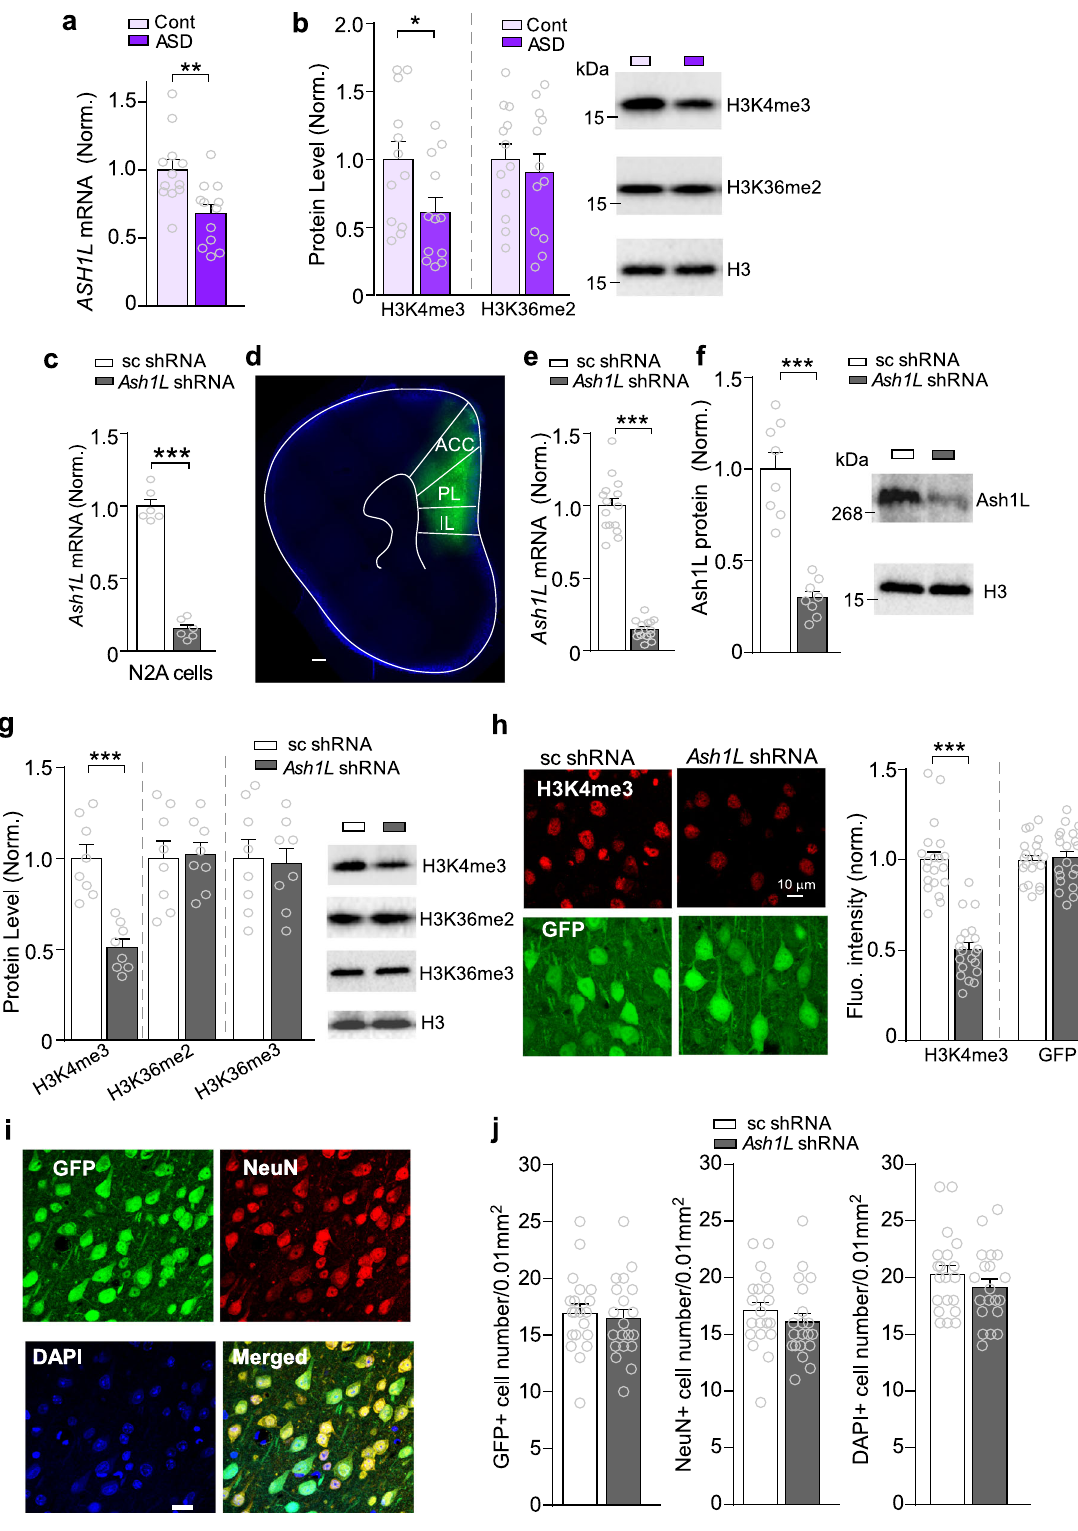
dual-localized synaptic proteins (including CntnAp1 and Nlgn1 ) (Fig. 2g, 55, P = 7.06e-15, hypergeometric test). In contrast, no signi fi cant overlapping was found among UP genes with excitatory or inhibitory synaptic proteins (Supplementary Fig.